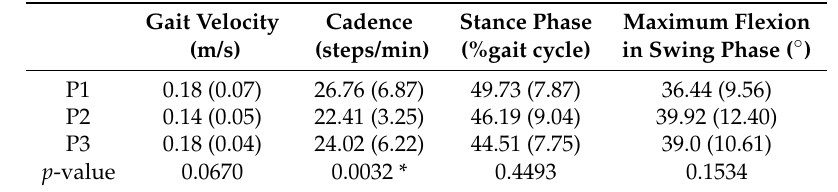
Table 1. Mean and standard deviation for temporospatial parameters, and maximum flexion during swing phase for subjects wearing the active knee orthosis controlled by the stance control strategy using three types of impedance modulation